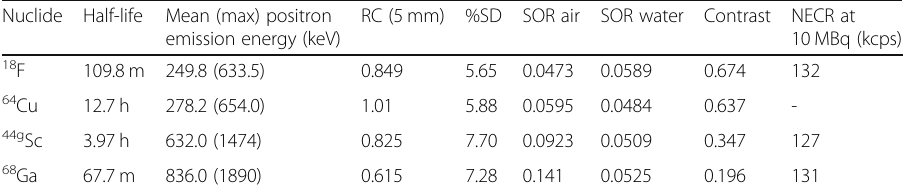
Table 3 Results from phantom imaging studies. The values reflect the FBP reconstruction for the NEMA Image quality phantom and Derenzo phantom